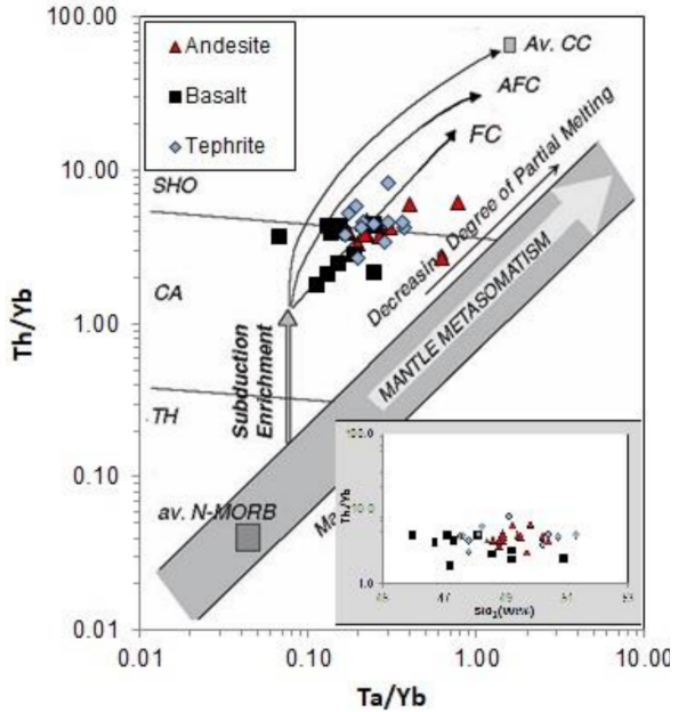
Figure 13. Th/Yb against Ta/Yb log–log diagram [111] for dyke swarm rocks from northwest of Iran. Shoshonitic rocks exhibit a consistent displacement from the mantle array indicating subduction- related metasomatism and/or crustal contamination. The inset diagram shows the variations of Th/Yb with changing silica contents of the rocks.